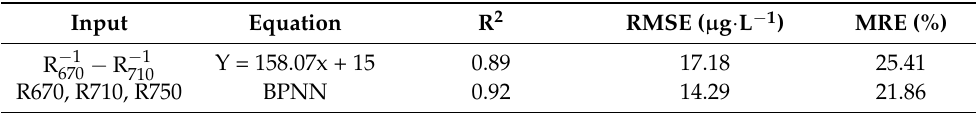
Table 6. The three-band (R670, R710, R750) models for Chl-a